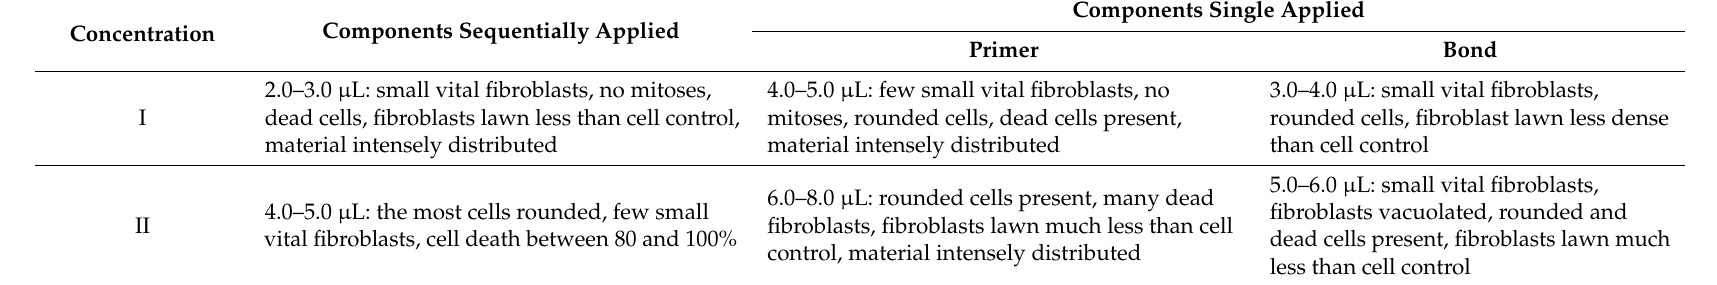
Table 7. Qualitative evaluation: Clearfil SE Bond (No. 4).